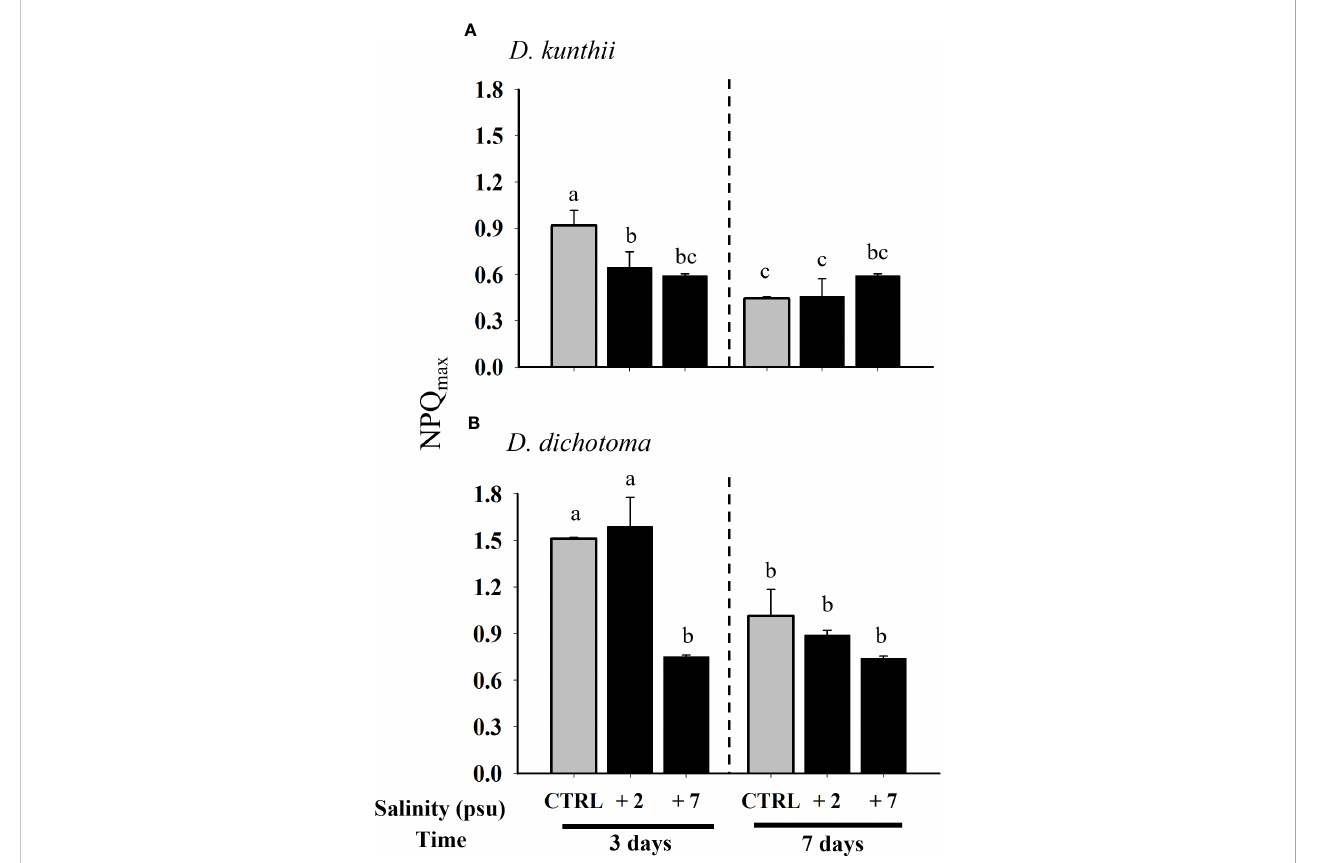
FIGURE 3 Maximal non-photochemical quenching (NPQmax) in D. kunthii (A) and D. dichotoma (B) exposed to high salinity values. For D. kunthii , the salinityvalues were 35 psu (control), 37 (+2) psu, and 42 (+7) psu; for D. dichotoma , these were 37 psu (control), 39 (+2) psu, and 44 (+7) psu. The sampleswere analyzed after 3 and 7 days. Data corresponds to mean ± SD (n = 3). Letters represent statistical difference at 95% con fi dence interval (Student – Newman – Keuls test, p <